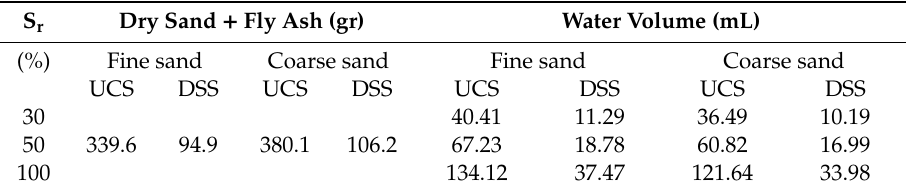
Table 4. The amount of material used, unconfined compressive strength (UCS), and direct shear strength